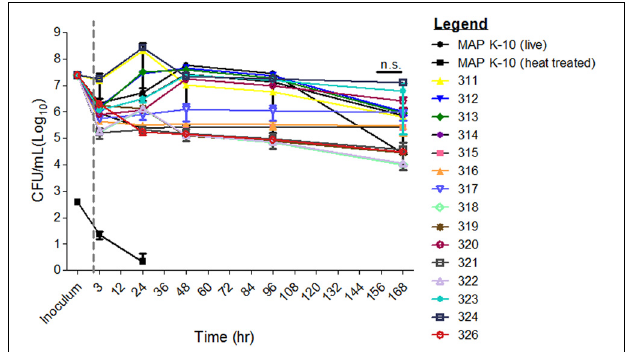
FIGURE 1 | Survival of MAP mutants in a primary cell in vitro bovine MDM model. All MAP mutant inoculums were normalized to that from MAP strain K-10. Bovine MDMs were incubated at 3, 24, 48, 96, and 168h. and subsequently lysed for MAP CFU culture. MAP mutant CFU counts did not differ significantly from the control, MAP strain K-10. Error bars represents standard error from the mean (s.e.m). Experiment represents data from 2 cows from the University of Minnesota. All time points were conducted in triplicate. n.s. is abbreviated for not significant. Gray line separates inoculum from the infection time